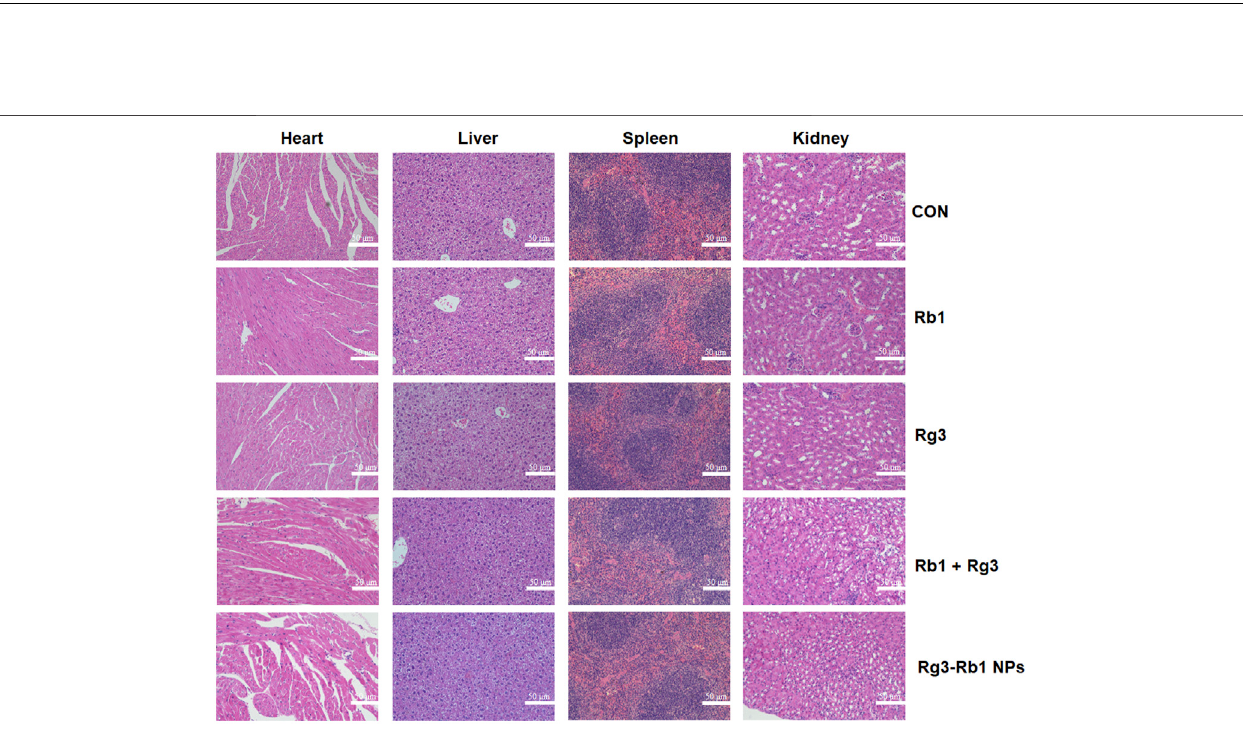
Frontiers in Bioengineering and Biotechnology |